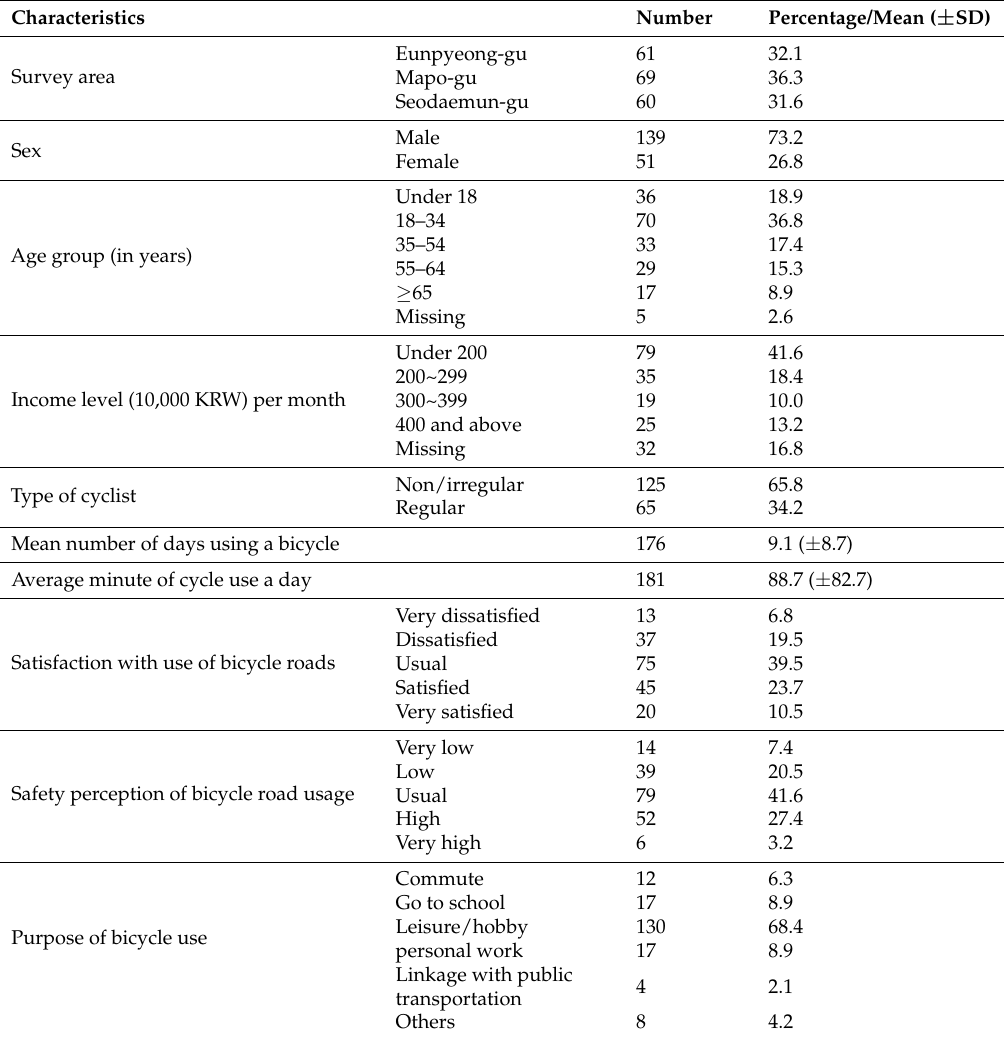
Table 2. Characteristics of the study